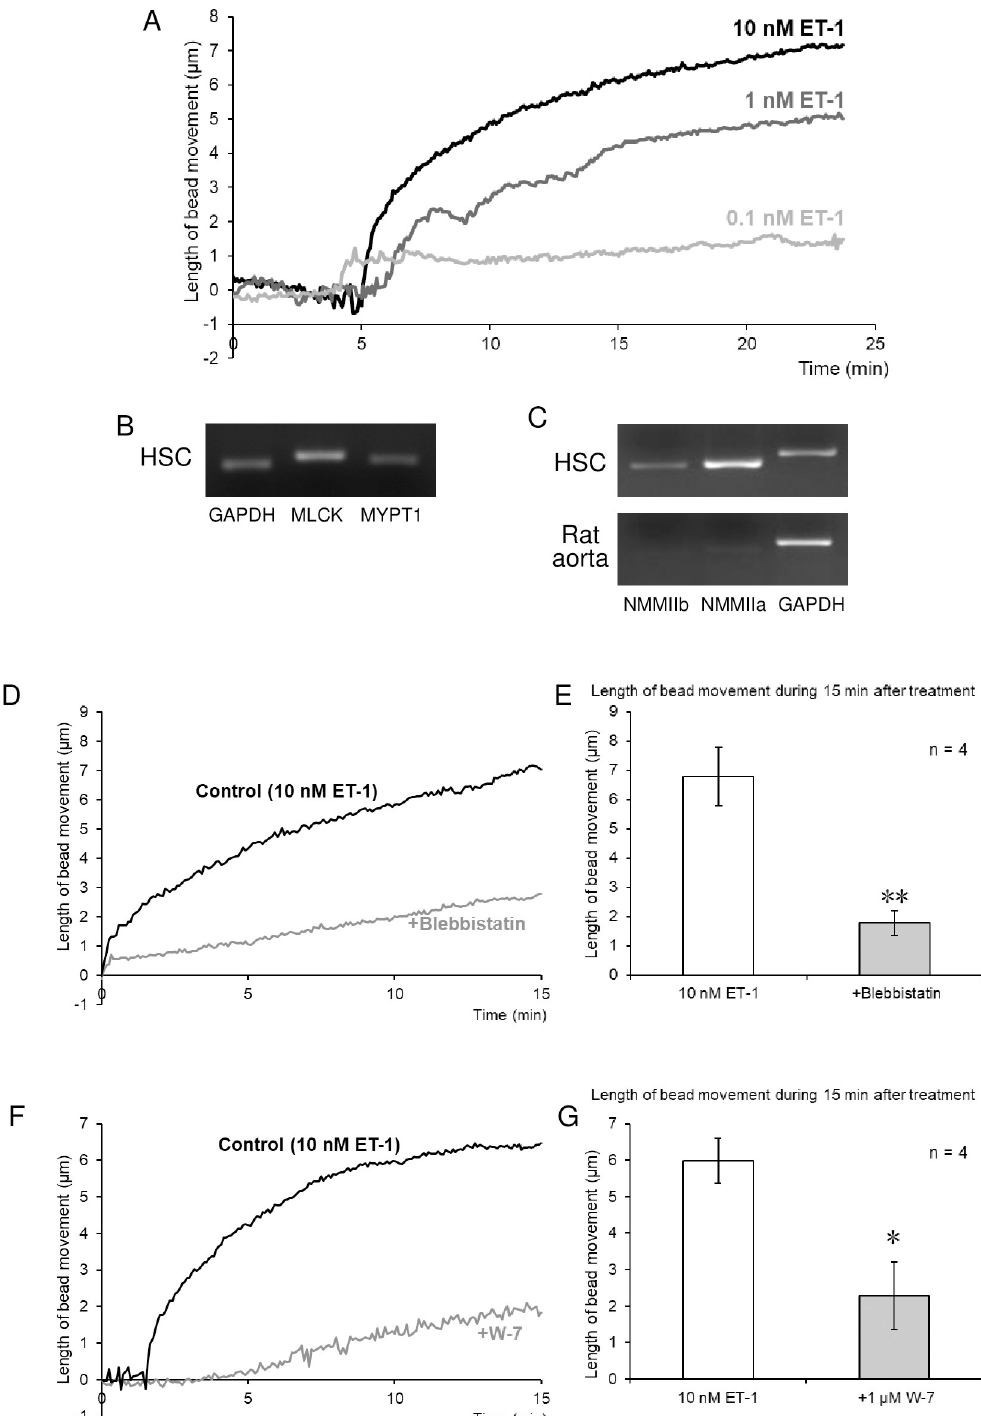
Fig 2. Endothelin-1 (ET-1)-induced contraction of isolated mouse non-activated HSCs. (A) Typical traces of non- activated HSC contraction. ET-1 induced concentration-dependent sustained contraction of non-activated HSCs. (B) RT-PCR analysis of mRNA expression of myosin light chain kinase ( MLCK ) and myosin phosphatase target subunit 1 ( MYPT1 ) in non-activated HSCs. (C) RT-PCR analysis of mRNA expression of non-muscle myosin IIa and IIb ( NMM IIa , IIb ), and IIb in non-activated HSCs and rat aorta. Effects of the selective NMM inhibitor blebbistatin (D, E) and the calmodulin inhibitor W-7 (F, G) on ET-1-induced contraction. Traces represent a typical time-course of changes in the